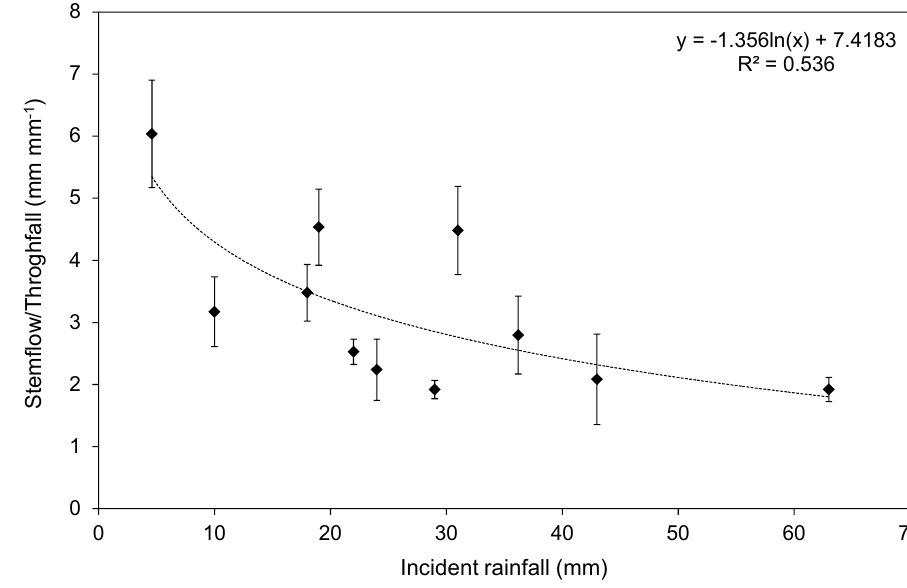
Figure 8. Relationship between total rainfall amounts and stemflow/throughfall ratio. Error bars indicate standard